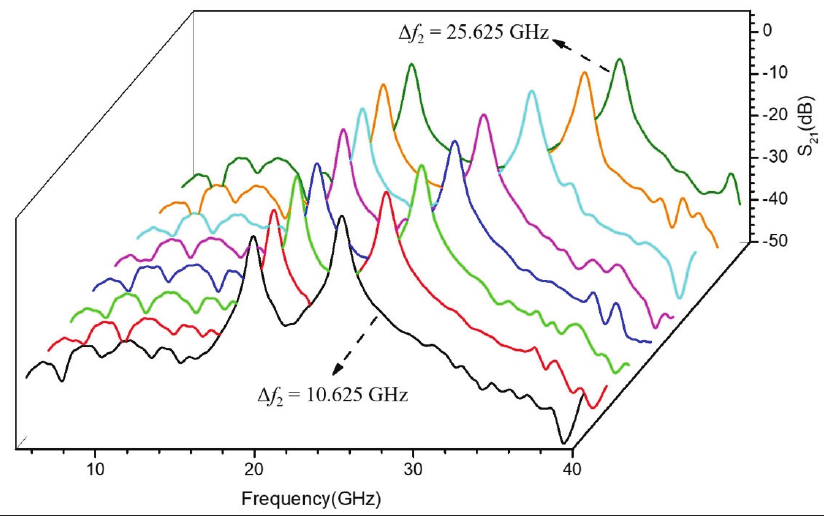
Figure 4. Results of the tunability of passband 2 by adjusting the detuning frequency ∆ f 2 .